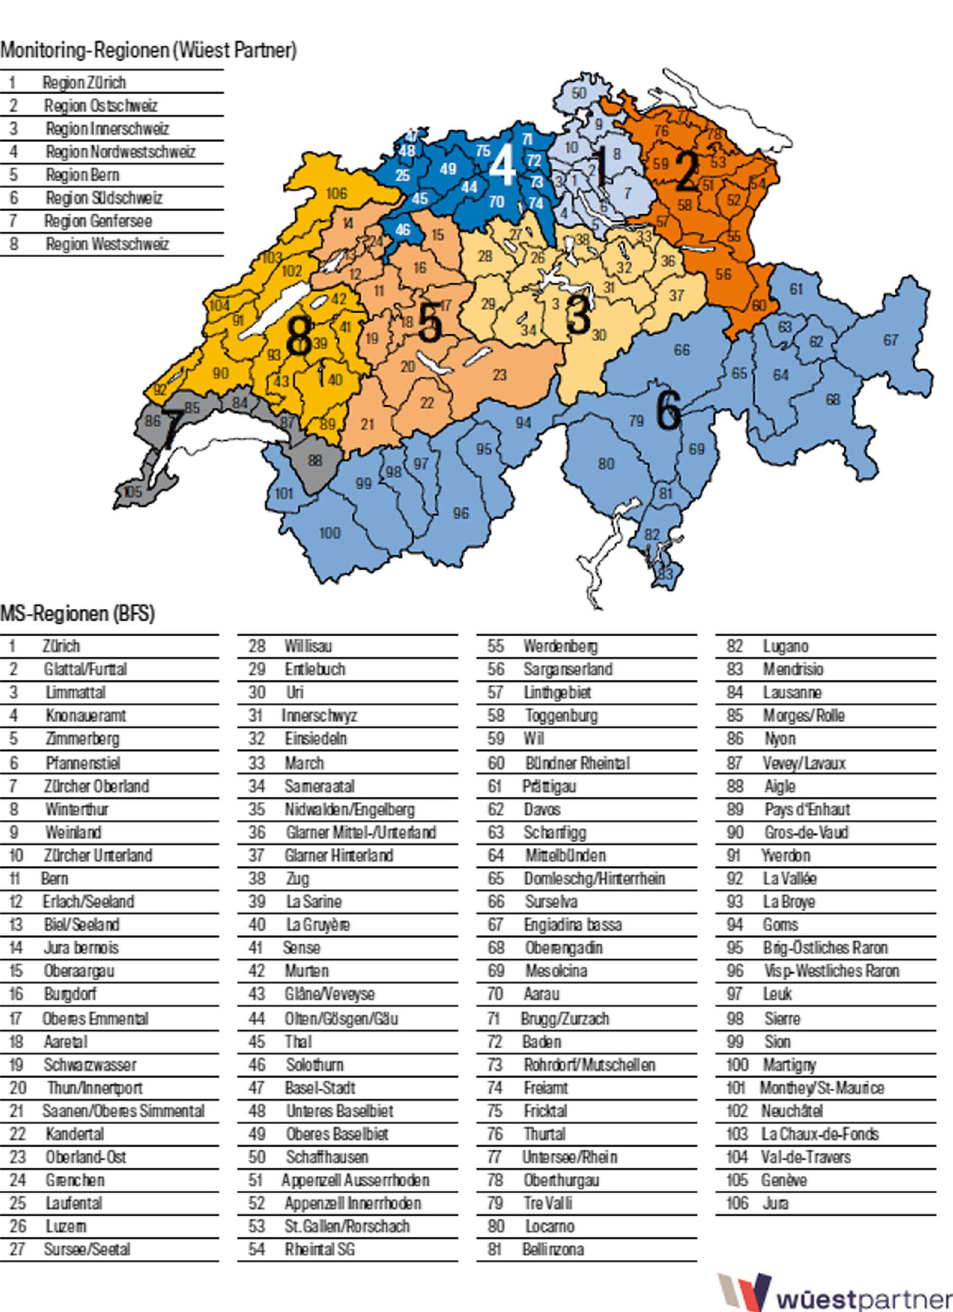
Fig. 9 MS-regions in Switzerland. Source: Wüest Partner